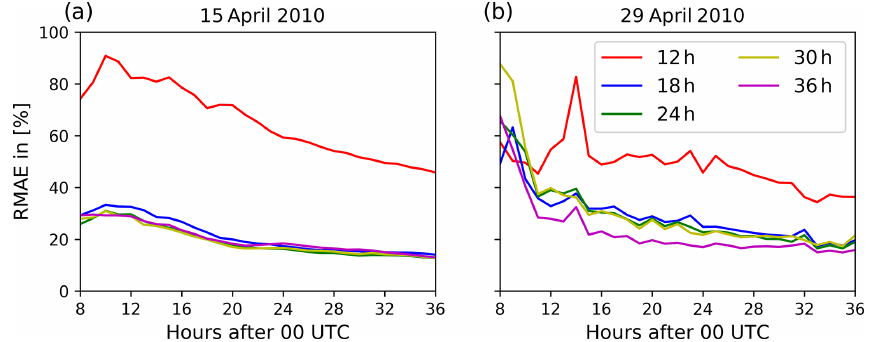
Figure 8. Relative mean absolute error of the volcanic ash concentrations defined by Eq. (9) for the eruption on (a) 15 April 2010 and on (b) 29 April 2010. The different lines indicate different assimilation window lengths from 12h (red) to 36h (magenta) as defined by Fig. 3.